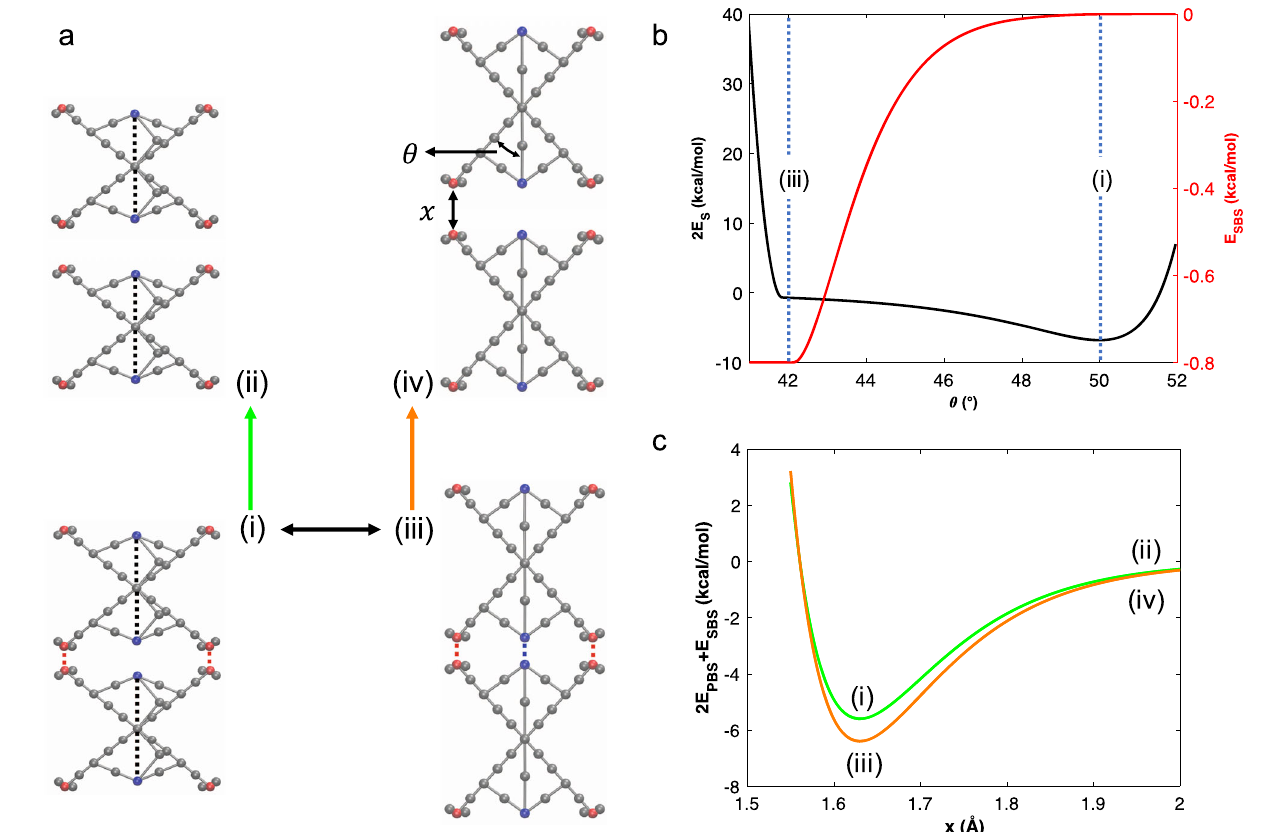
Fig. 4 X-shaped nanoparticles form a biphasic system with two unbinding pathways. a Snapshots (i) and (iii) are the LA state and HA state, respectively. Snapshots (ii) and (iv) are the unbound dimers. The black line indicates the transition pathway of the dimer between its LA and HA states. The green line is the LA unbinding pathway and the orange line is the HA unbinding pathway. The reaction coordinates, namely interparticle distance x and intraparticle angle θ , are marked in snapshot (iv). b Energy landscapes for the LA-to-HA-state transition as a function of intraparticle angle θ . The transition energy landscape (black curve) is between the complementary halves of two nanoparticles and is the sum of two switch interactions. E SBS (red curve) shows that in the LA state, SBS has no contribution to the interaction between the particles; however, in the HA state complementary SBSs interact. c Energy landscapes for the LA to HA unbinding as a function of interparticle distance x . The curves follow the same color code as the pathways. HA unbinding has a larger barrier due to E SBS contributions.